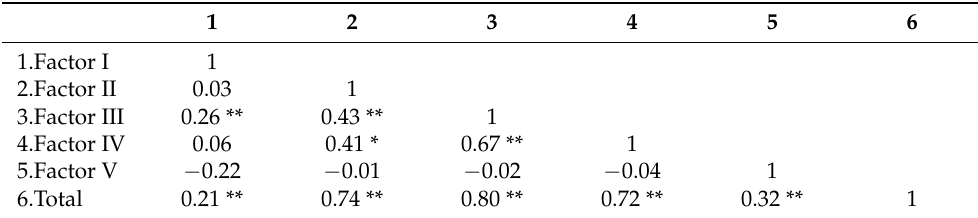
Table 3. Pearson correlation analysis between factors.